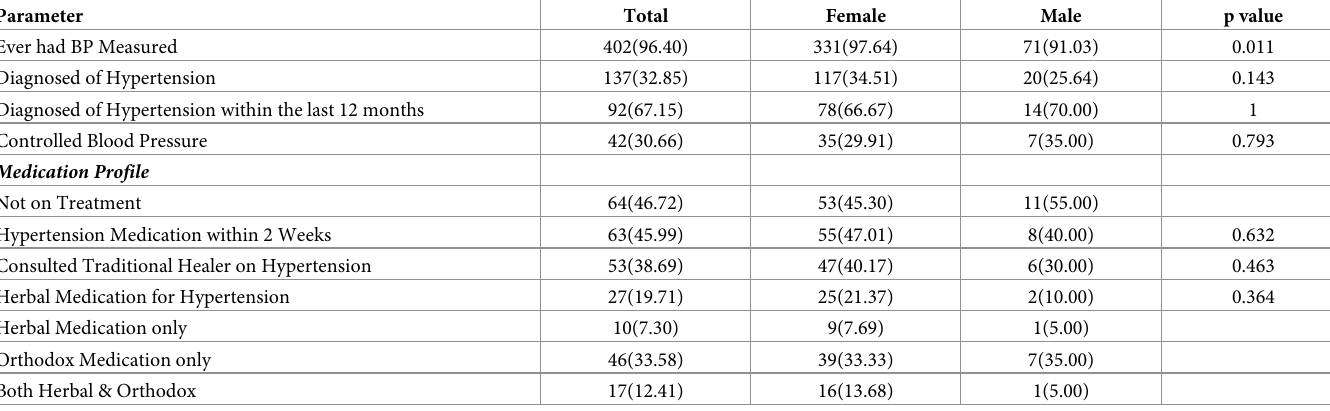
medication and orthodox medication for hypertension management respectively. The level of controlled blood pressure recorded among known hypertension was 30.66% overall, 29.91% among the female subgroup, and 35.00% among the males (Table 2).